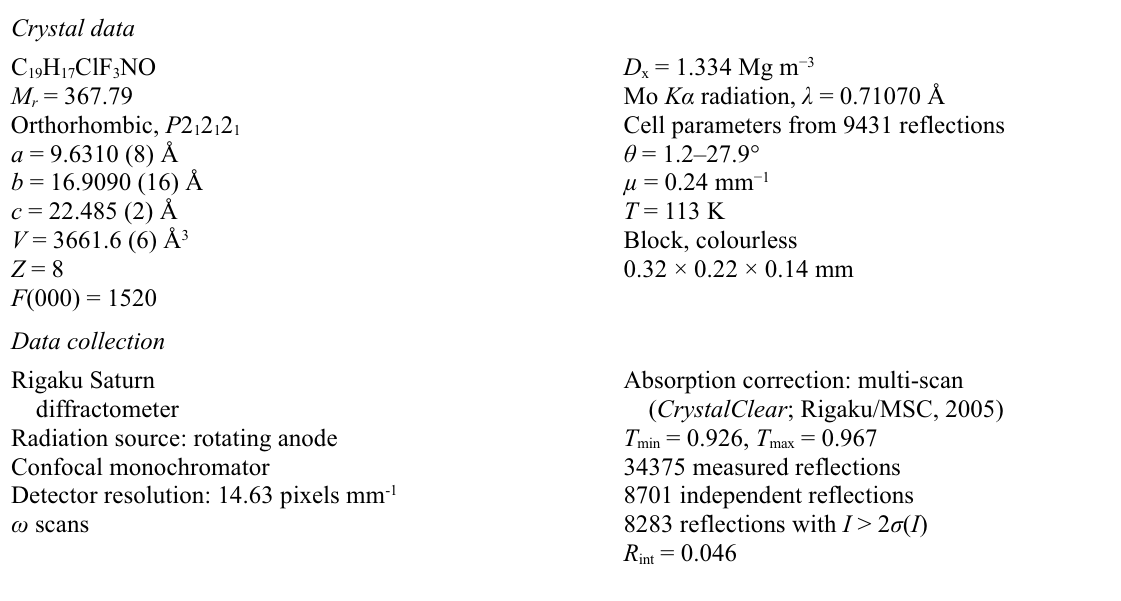
The crystal structure of (I), methanol, viewed along b axis ( E )-3-(2-Chloro-3,3,3-trifluoroprop-1-enyl)-2,2-dimethyl- N